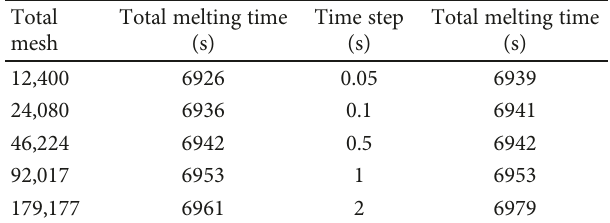
Table 2: The results of mesh independent and time step independent